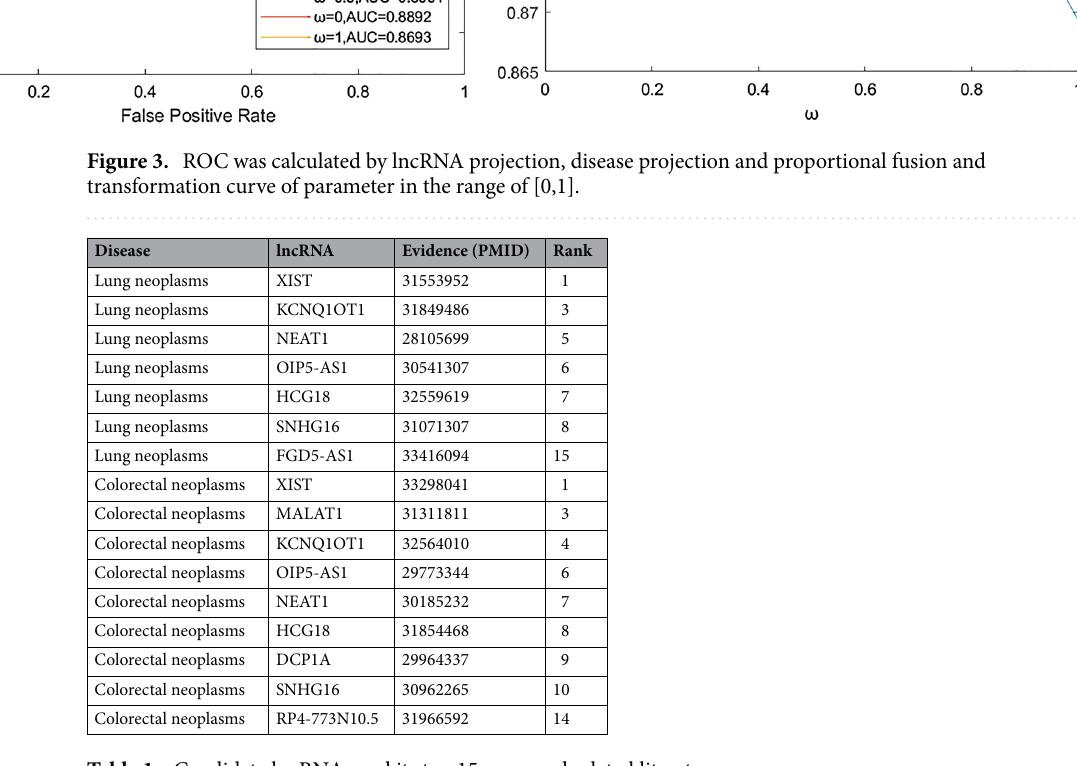
Table 1. Candidate lncRNAs and its top 15 cases and related